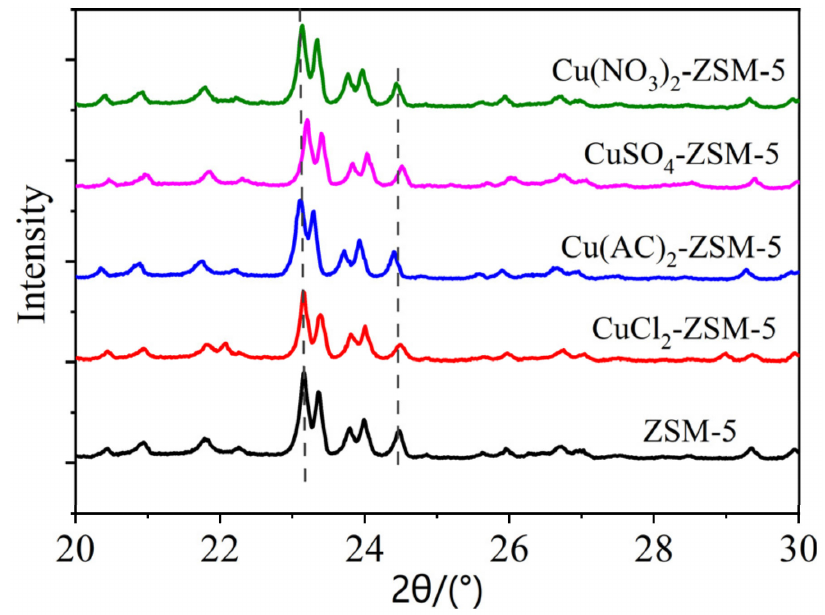
Figure 2. Wide angle XRD atlas of ZSM-5 (black), 2.5% CuCl 2 -ZSM-5 (red), 1.5% Cu(AC) 2 -ZSM-5 (blue), 2.5% CuSO 4 -ZSM-5 (pink), and 4.0% Cu(NO 3 ) 2 -ZSM-5